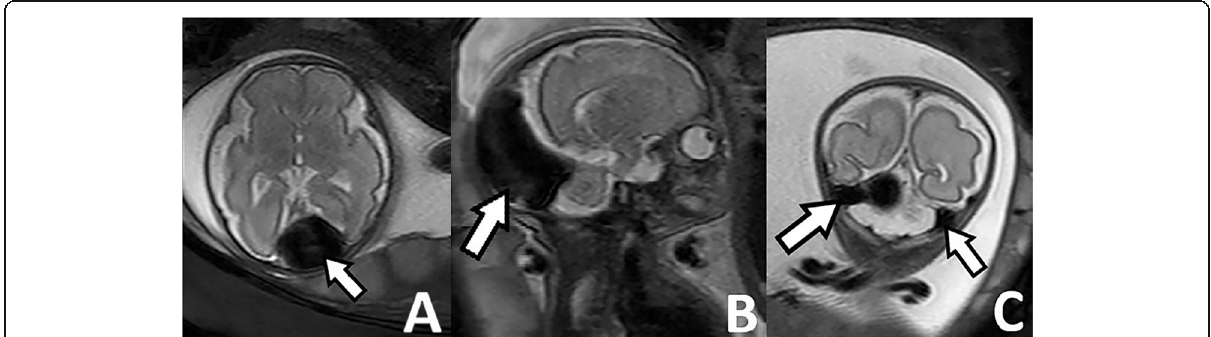
Fig. 1 Fetal MRI at 28 weeks 4 days — SS-TSE images of brain: A Axial, B sagittal and C coronal planes reveal abnormal ectatic torcula, posterior